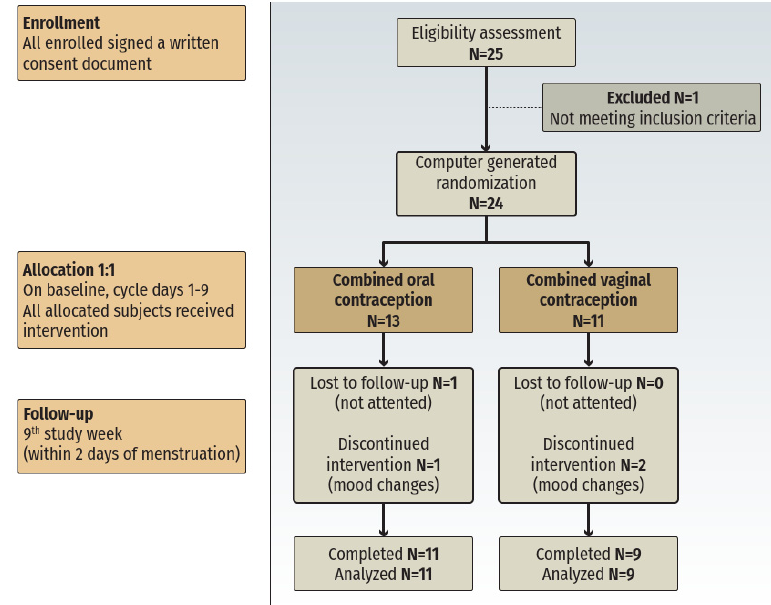
Figure 1. Flowchart of the study.